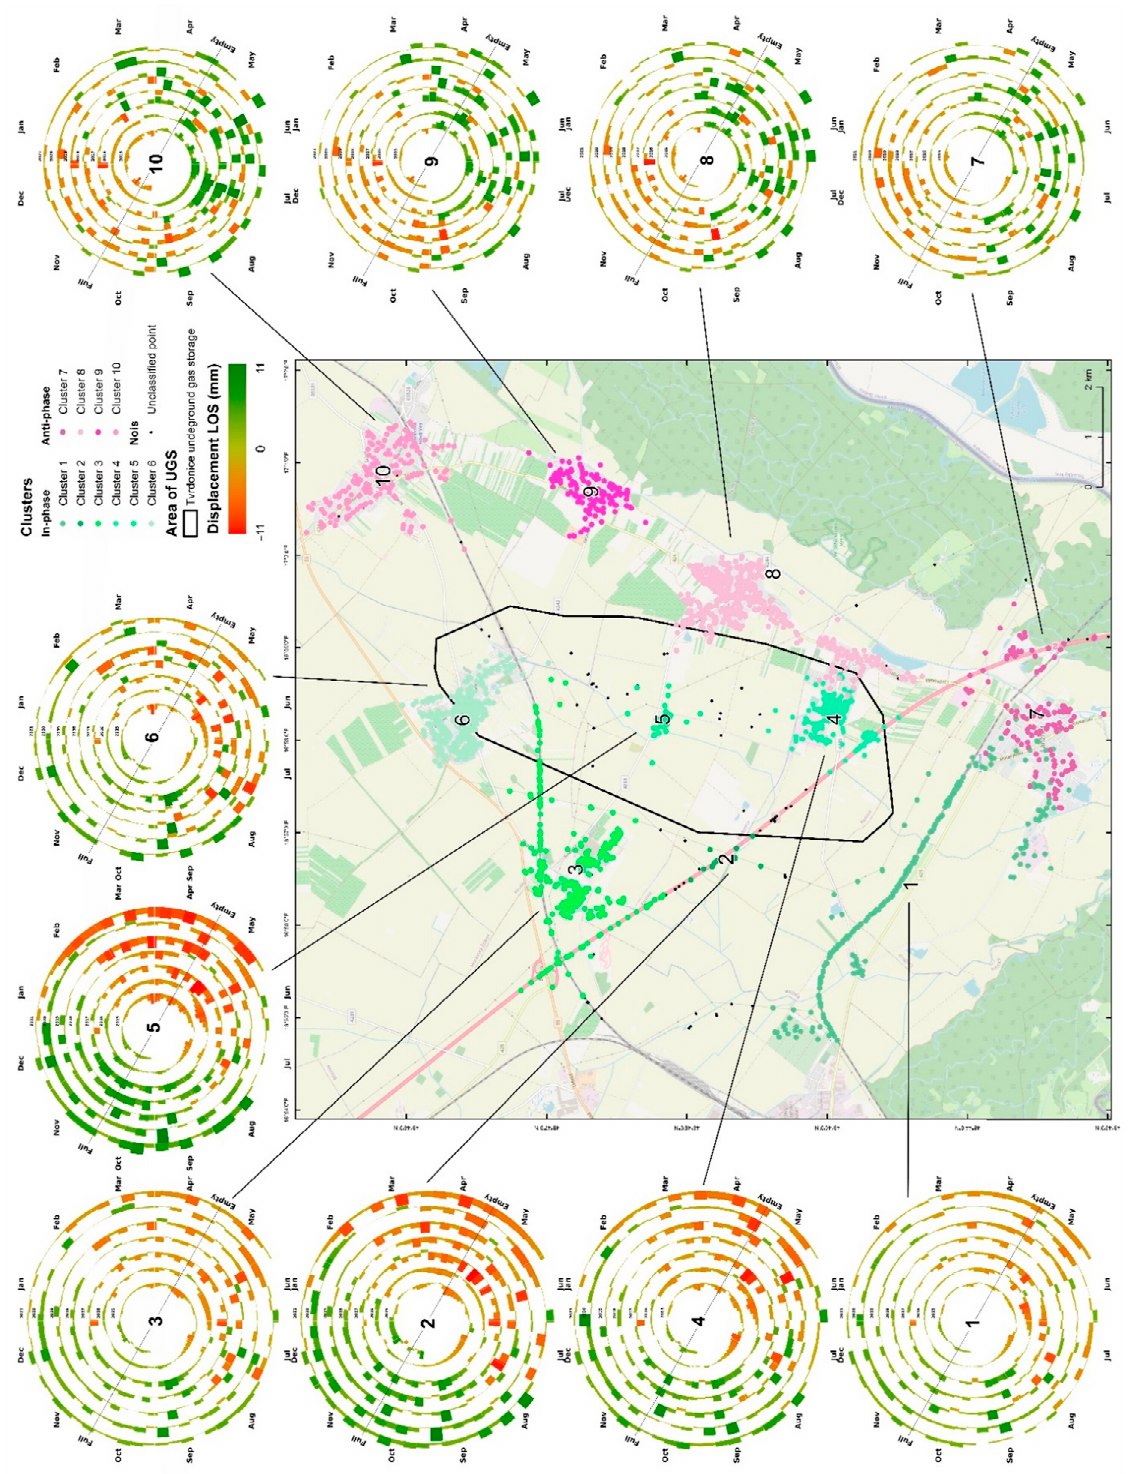
Figure A4. Map composition showing the distribution of clusters in the area and their corresponding spiral graphs.